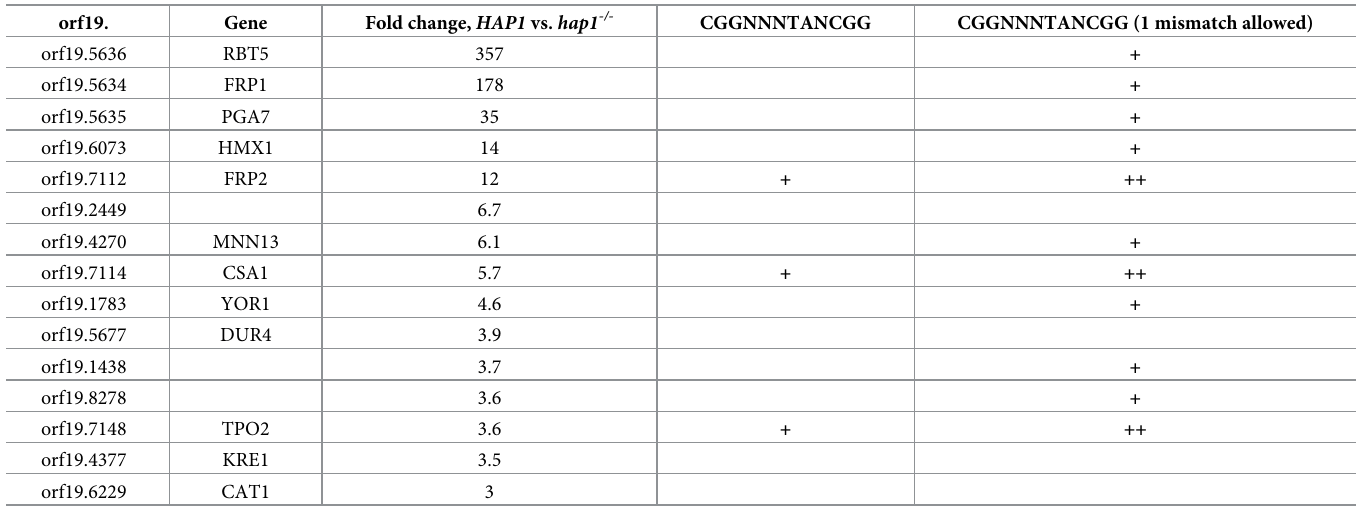
Table 2. Genes most dependent on Hap1. orf19.